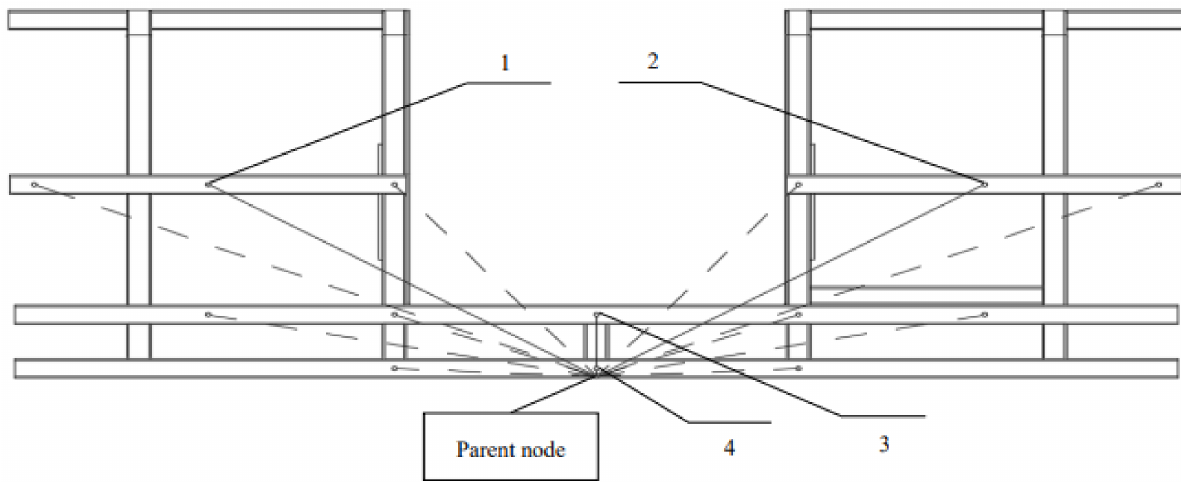
Figure 11. Schematic diagram of the rear interface node network of the front suspension frame module; the node numbers are referred to in Table